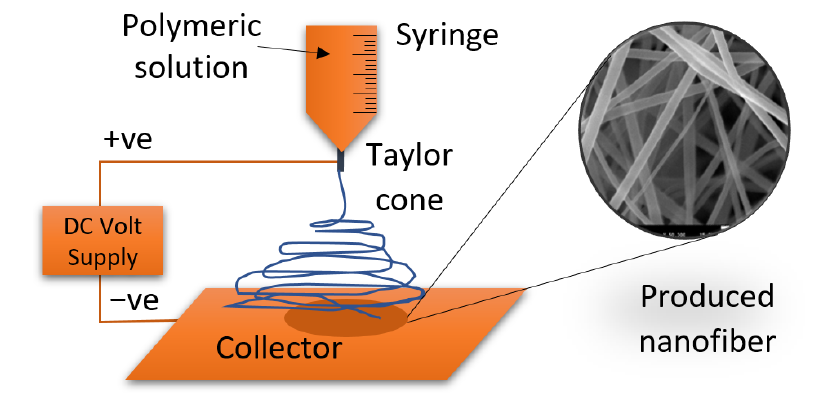
Figure 1. Schematic layout of the nanofiber electrospinning process.